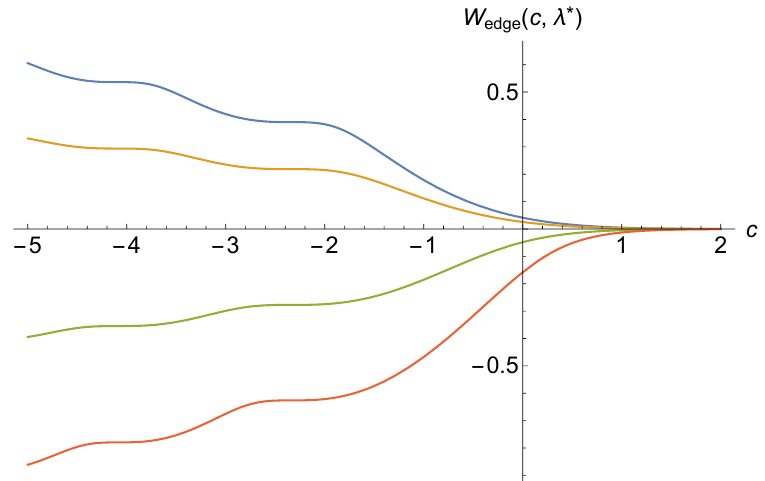
( c , λ ∗ ) felt by an impurity at the edge as a func- Figure 8: The scaled potential W edge tion of the distance c from the edge measured in units of w as give in Eq. (135). e Shown from top to bottom is the potential for λ ∗ = 1, 0.5, − 0.5, −